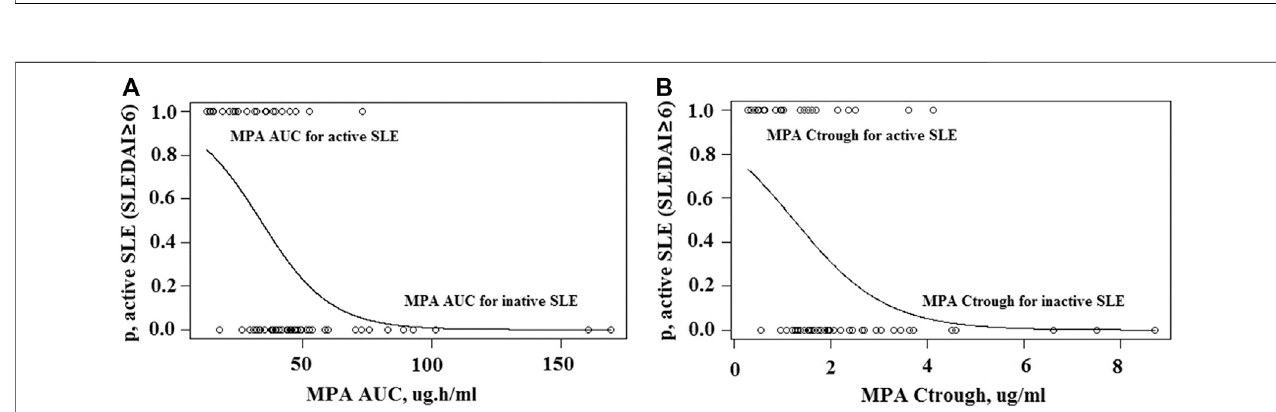
FIGURE 5 | Receiver operating characteristic (ROC) curve estimates for the 67 SLE patients. (A) , for MPA AUC (AUC ROC : 0.790; p < 0.0001). (B), for C trough (AUC ROC : 0.792; p < 0.0001).